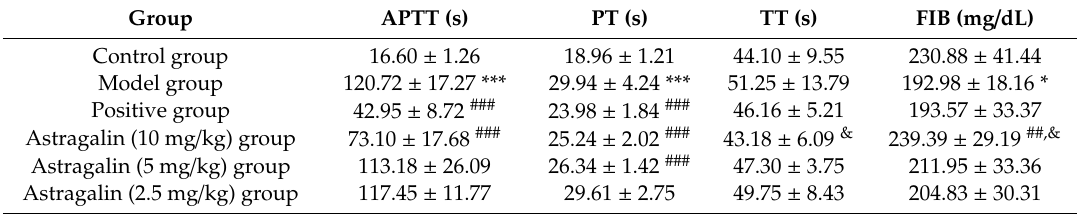
Table 5. E ff ect of astragalin on plasma coagulation parameters in vivo (X ± SD, n =